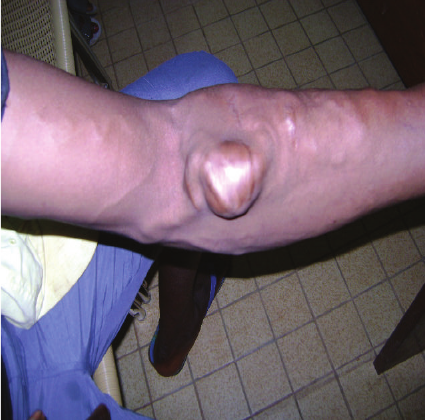
Figure 1: Posttraumatic AVF between the brachial artery and the vein comitans with a large pseudoaneurysm and massively distended superficial veins; the distension is from the venous comitans.